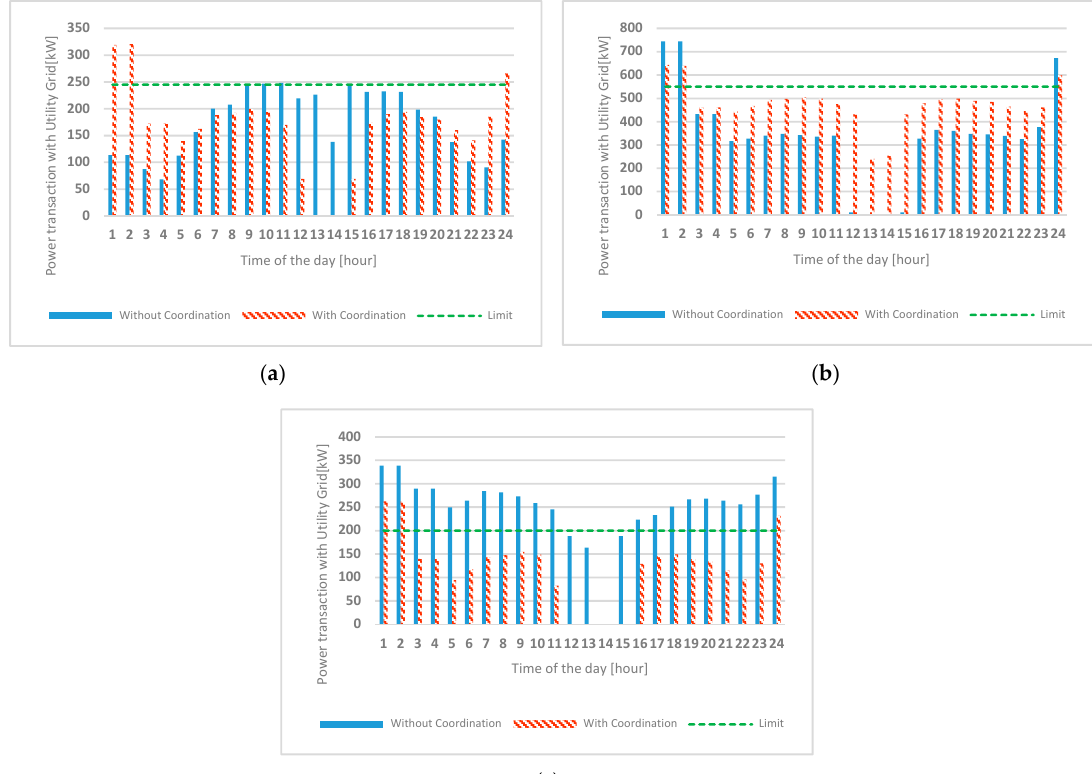
Figure 8. Power transaction with utility grid ( a ) MG1, ( b ) MG2, ( c ) MG3.